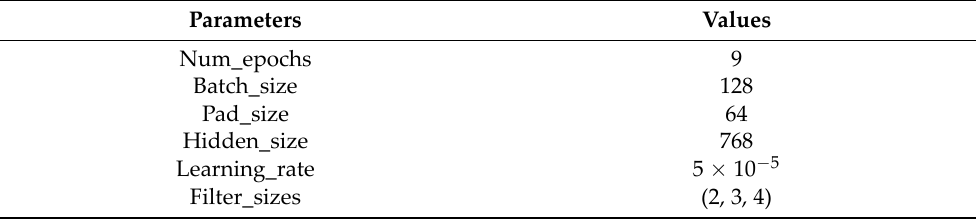
Table 2. Experimental parameter